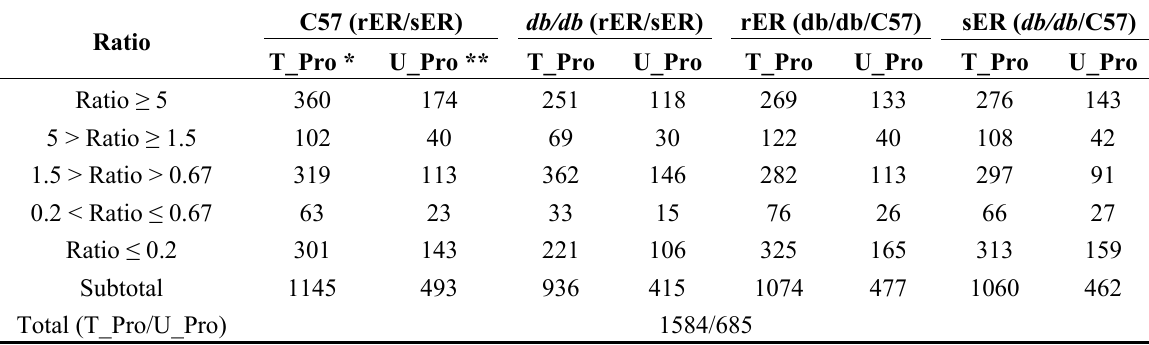
Table 1. Summary of quantitative analysis of ER proteome from normal and db/db